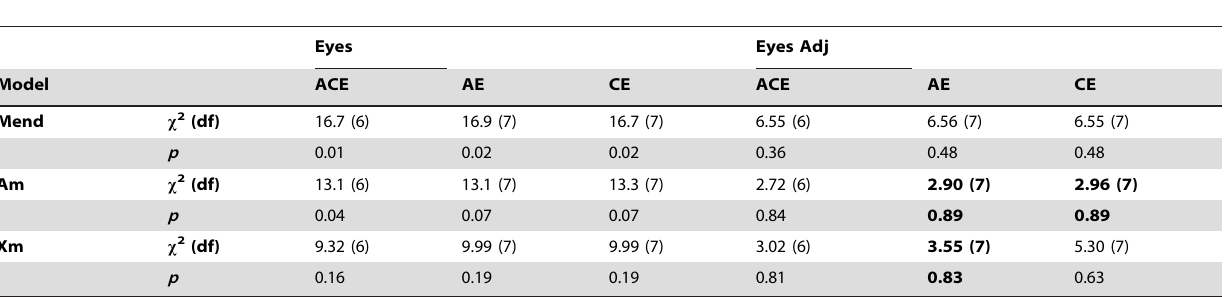
Table 4. Model-fitting statistics for Eyes and Eyes Adj testing Mendelian, maternal and X-linked maternal models of heritability.